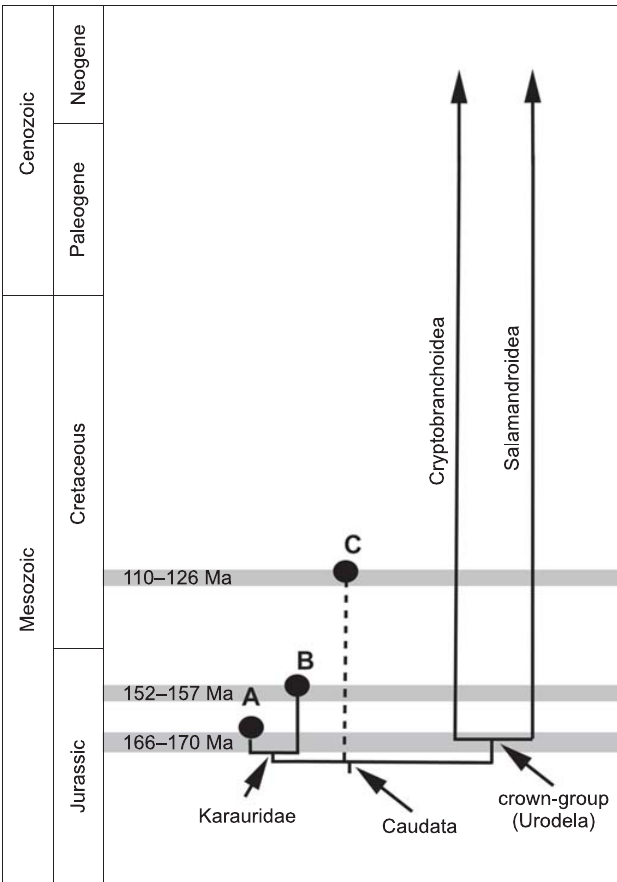
Fig. 2. Simplified relationships and temporal ranges of stem- and crown- group salamanders. Stem salamanders are represented only by Karauridae (i.e., Kokartus + Karaurus ). A, stratigraphic placement (Bathonian) of the stem salamander Kokartus (note that the stem salamanders Marmorerpe- ton , “Kirtlington salamander A”, Urupia , and “Berezovsk salamander A” have the same stratigraphic placements). B, stratigraphic placement (Kim- meridgian) of Karaurus (note that salamanders “cf. Marmorerpeton ” from Portugal and the possible “stem salamander” from the USA have approxi- mately the same stratigraphic placements). C, stratigraphic placement (Ap- tian–Albian) of the stem salamander Caudata, Gen. et sp. indet. reported here from the Shestakovo locality and possible stem salamanders from the Cloverly Formation of